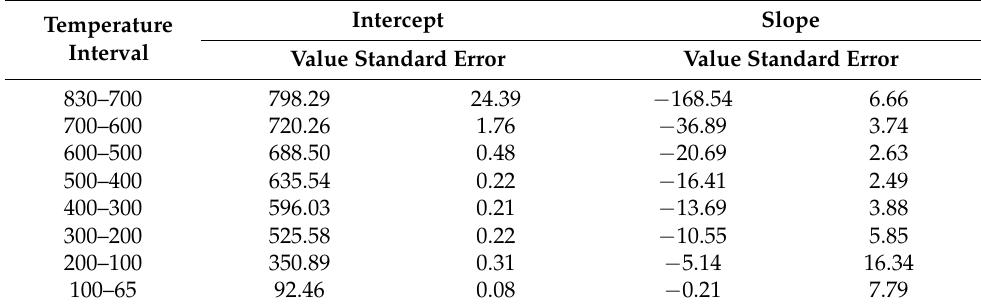
Table 3. The fitting function of node